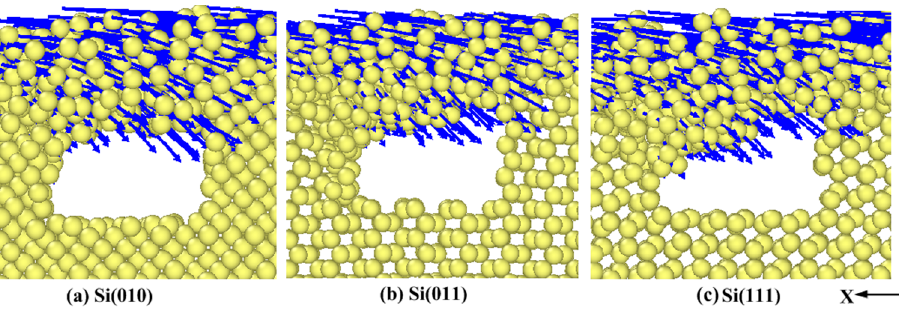
Figure 5. Effects of anisotropy on the deformation of the first pore at the polishing distance of 4 nm.